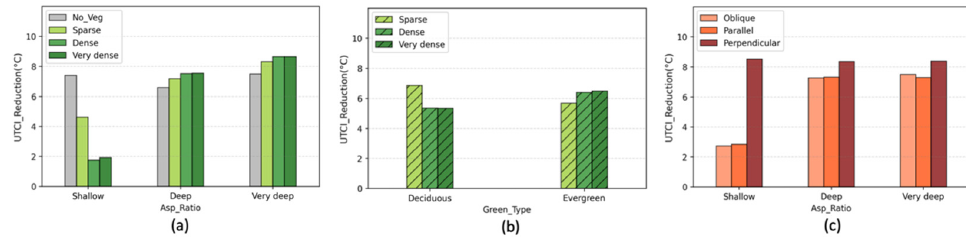
Figure 5. Comparison of cooling impact (average UTCI reduction) of parameters in different contexts (At 15:00). ( a ) the interaction between aspect ratio and green density ( b ) the interaction between green type and green density ( c ) the interaction between aspect ratio and canyon orientation.